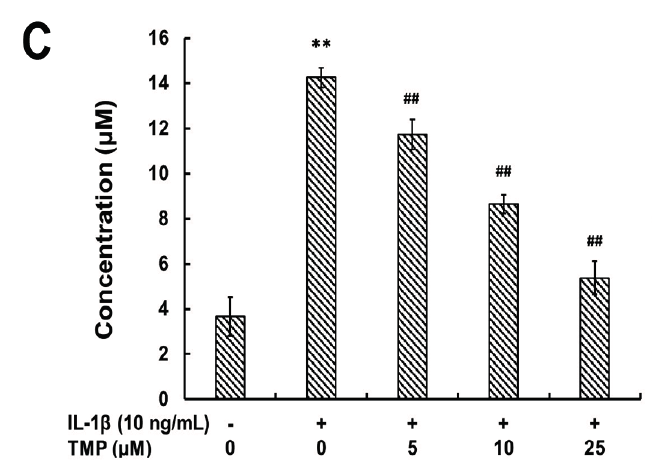
Figure 1. Effect of TMP on IL-1 β -induced iNOS and NO expression in TR-iBRB2 cells. After treatment of indicated drugs, the relative mRNA and protein expressions of iNOS were assessed by RT-PCR ( A ) and Western blot analysis ( B ); Nitrite levels of the TR-iBRB2 cells were determined by Griess assay ( C ). All data were expressed as mean ± SD of three experiments and each experiment included triplicate repeats. ** p < 0.01 vs. control group;